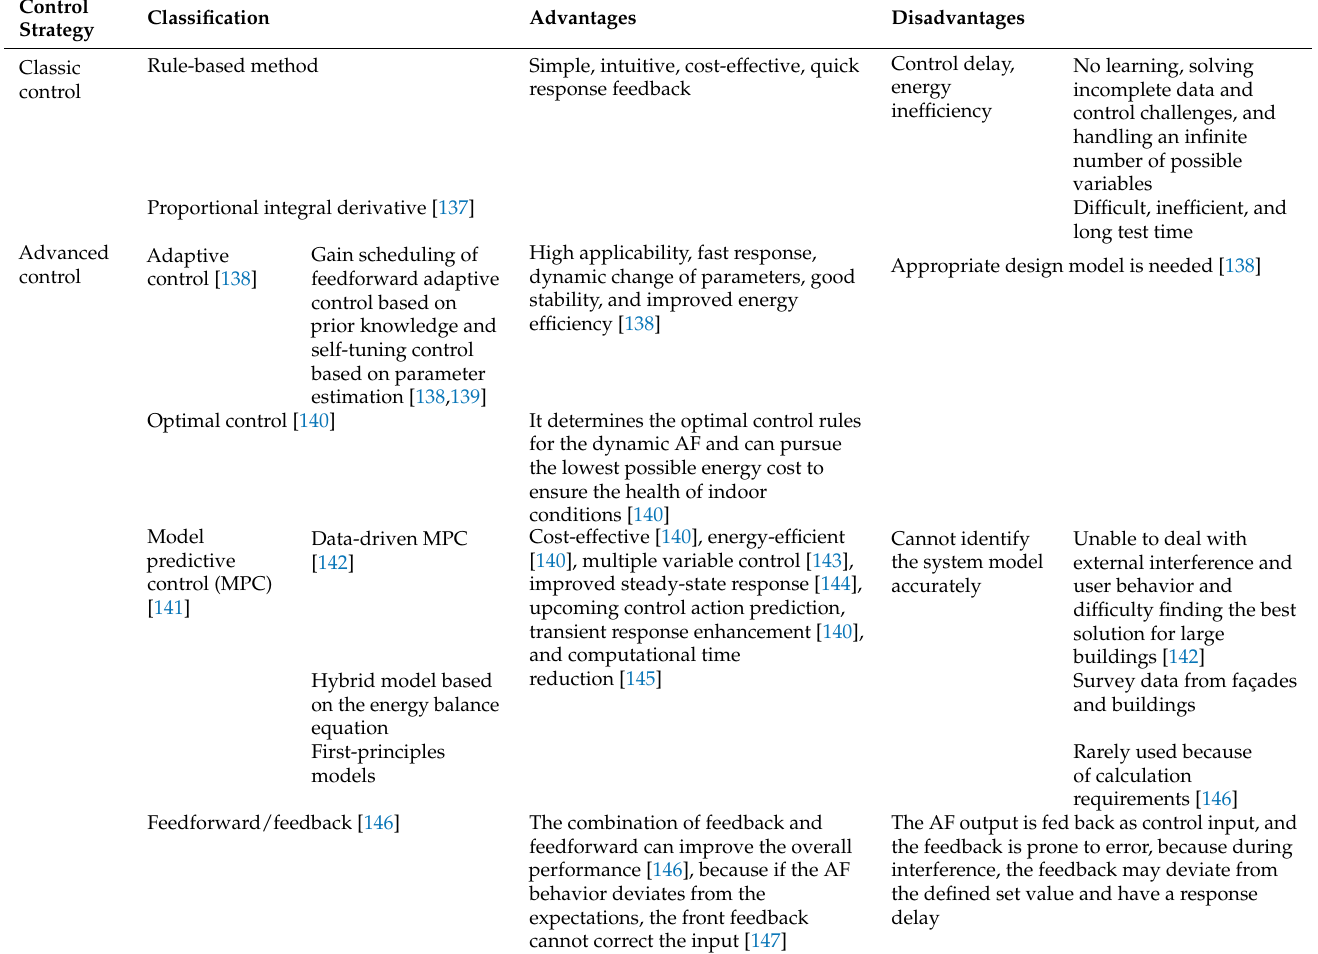
Table 7. Classification, advantages, and disadvantages of control